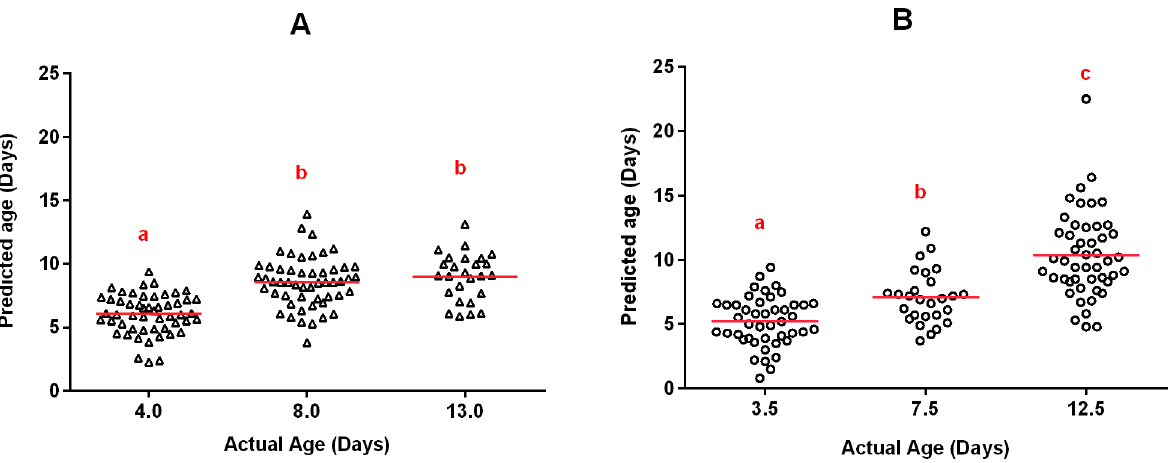
Figure 2. NIRS age predictions for A. resistant and B. susceptible laboratory reared Anopheles spp after 24-hr holding period post insecticide exposure. NIRS predictions that differ significantly between the different age groups at the 0.05 level are marked with a different letter. Mean age predictions are indicated by a red line.